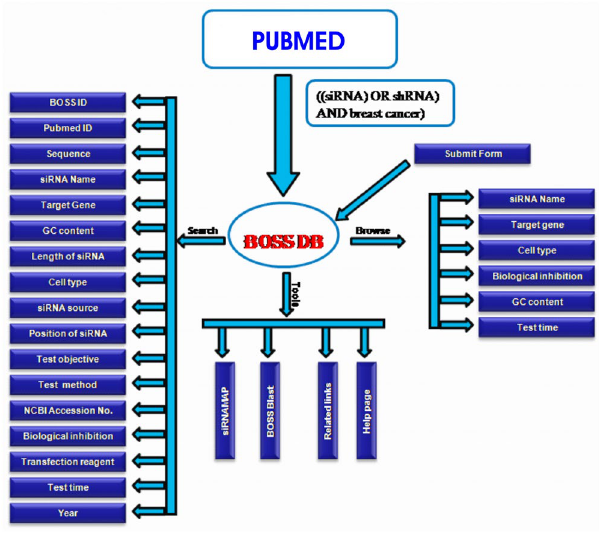
Figure 1. Systematic representation of BOSS database